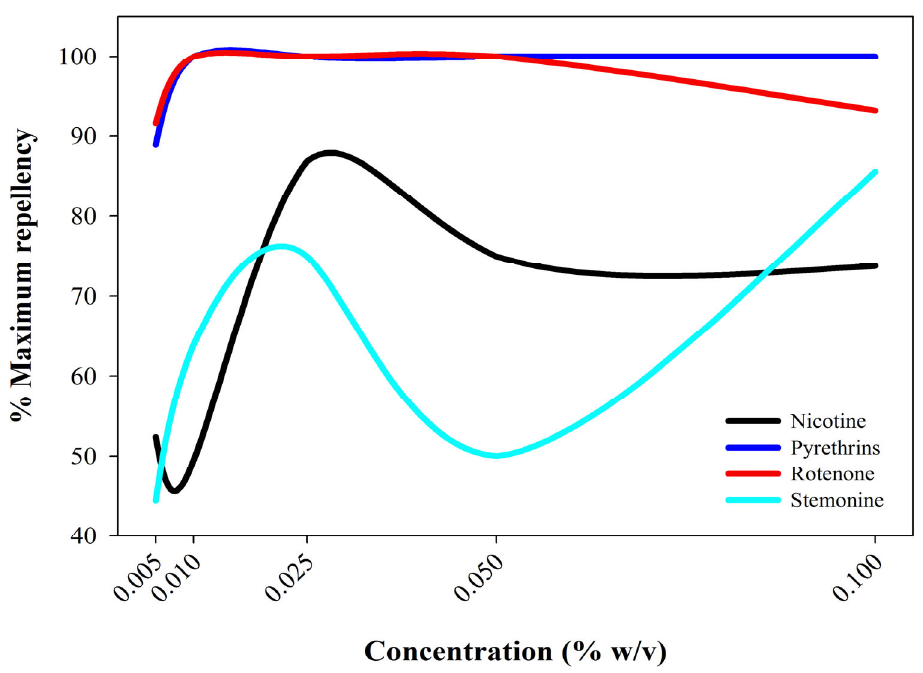
Figure 1. Mean maximum percent repellency achieved by varying concentrations of plants extracts in the two ‐ choice repellency, multiple ‐ concentrations bioassays .